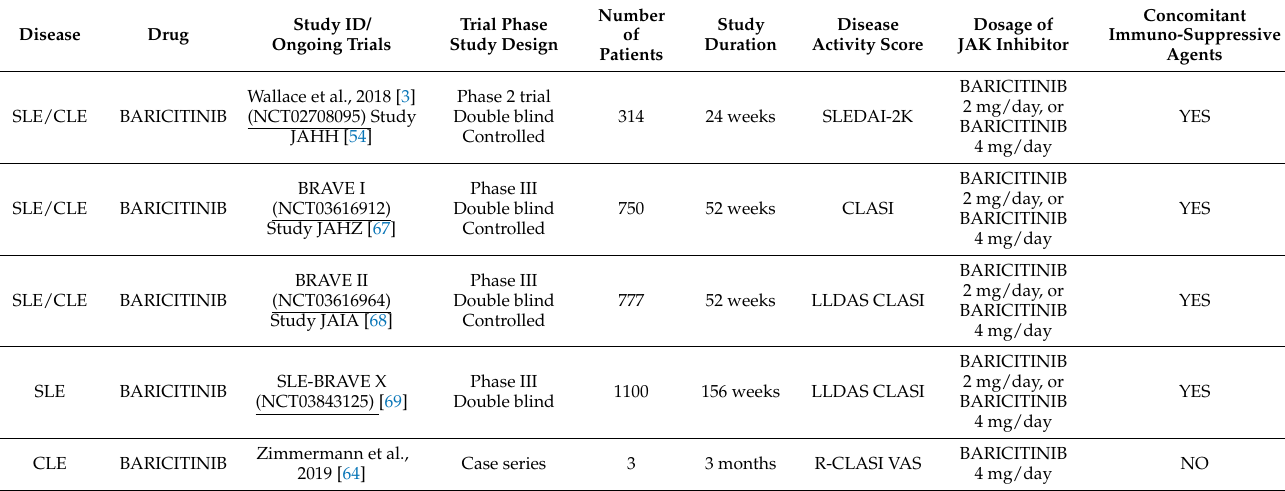
Table 3. Baricitinib-main case reports and clinical